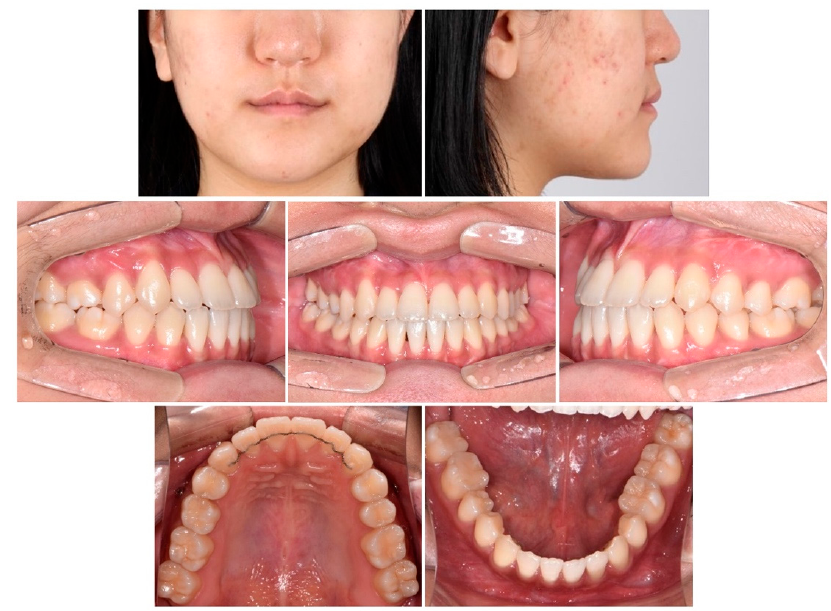
Figure 6. Intraoral and extraoral photographs after debonding.